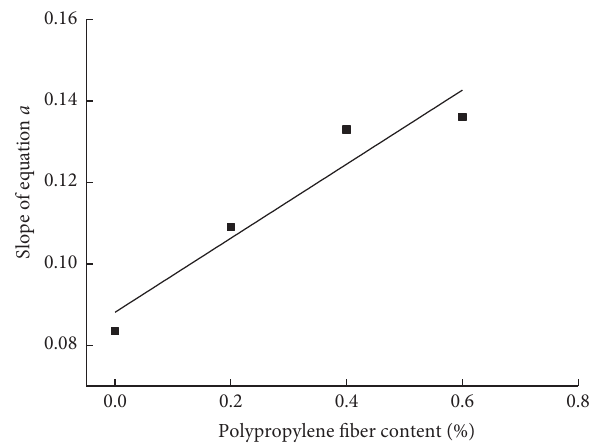
Figure 8: Relationship between the polypropylene fiber content and the slope of dynamic improvement coefficient equation